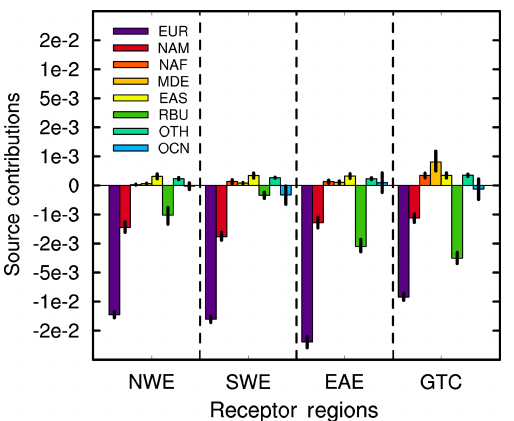
Figure 9. Absolute contributions (per decade) of the emissions from major source regions to the trends of sulfate AOD over the four sub- regions of Europe. Error bars represent 95% confidence intervals of the linear regression.